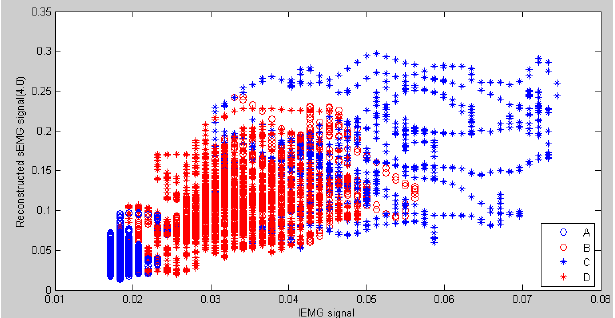
Figure 13. Example of a scatter figure on the integrated EMG (IEMG) signals and MAV of reconstructed sEMG signals in node 4.0. sEMG signals in node